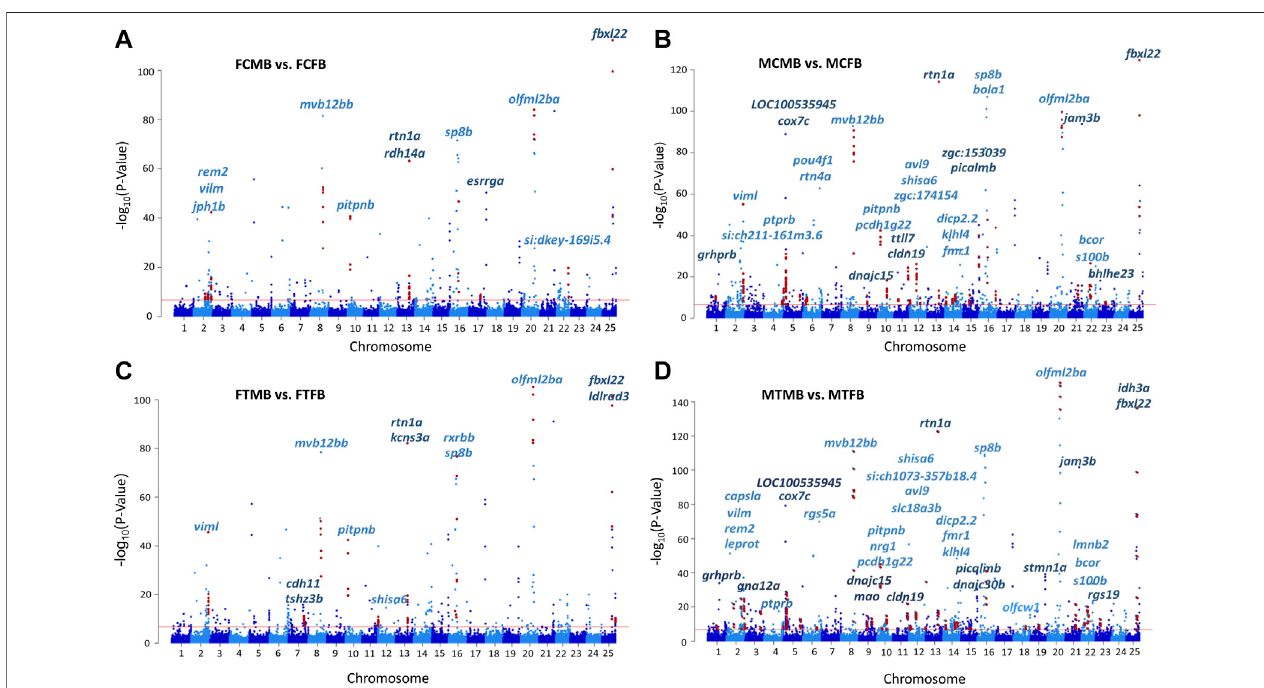
FIGURE 5 | Chromosomal distribution of differentially methylated CpG sites (DMCs) in zebra fi sh gonad. (A) female control male-biased versus female control female-biased (FCMB vs. FCFB); (B) male control male-biased versus male control female-biased (MCMB vs. MCFB); (C) female treatment male-biased versus female treatmentfemale-biased(FTMBvs.FTFB); (D) maletreatmentmale-biasedversusmaletreatmentfemale-biased(MTMBvs.MTFB).EachdotrepresentsaCpGsitewith genomic position on the x -axis and – log 10 ( p -value) for differentially methylation between different experimental groups on the y -axis. Red dots represent the genomic distribution of DMCs associated with signi fi cantly differential genes comprising at least four methylated positions ( fi fth percentile of distribution). The corresponding gene names are displayed on top of the chromosomes. Red line represents the signi fi cance at Bonferroni threshold < 0.05.